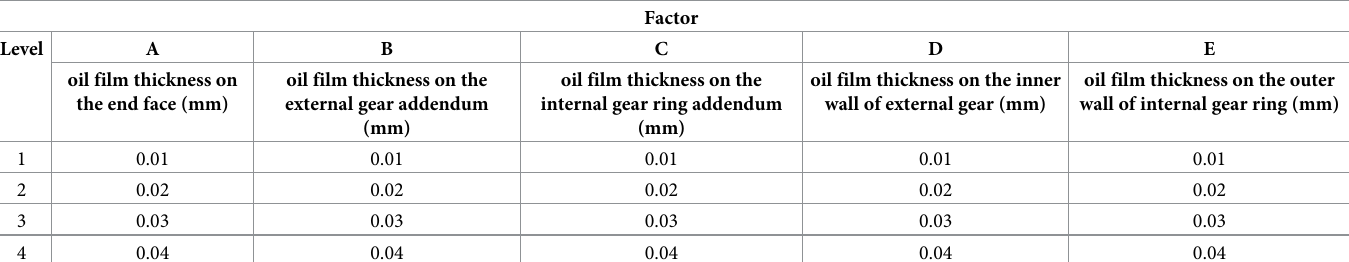
Table 1. Factor level table.